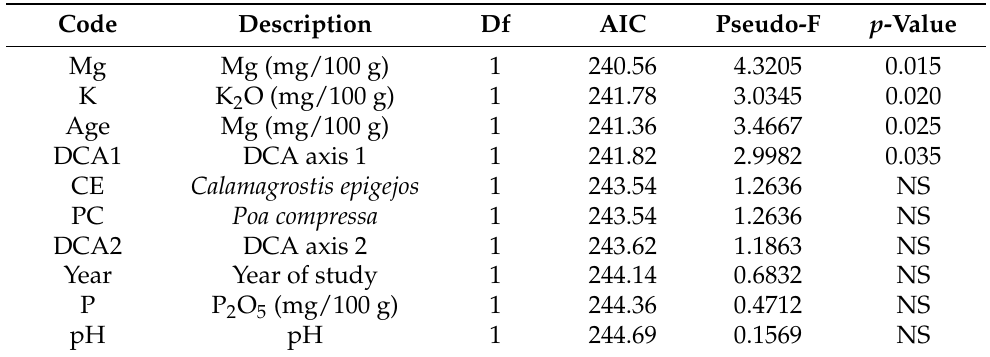
Table 3. The inclusion of analyzed factors in the RDA model showing their impact on root coloniza- tion of studied